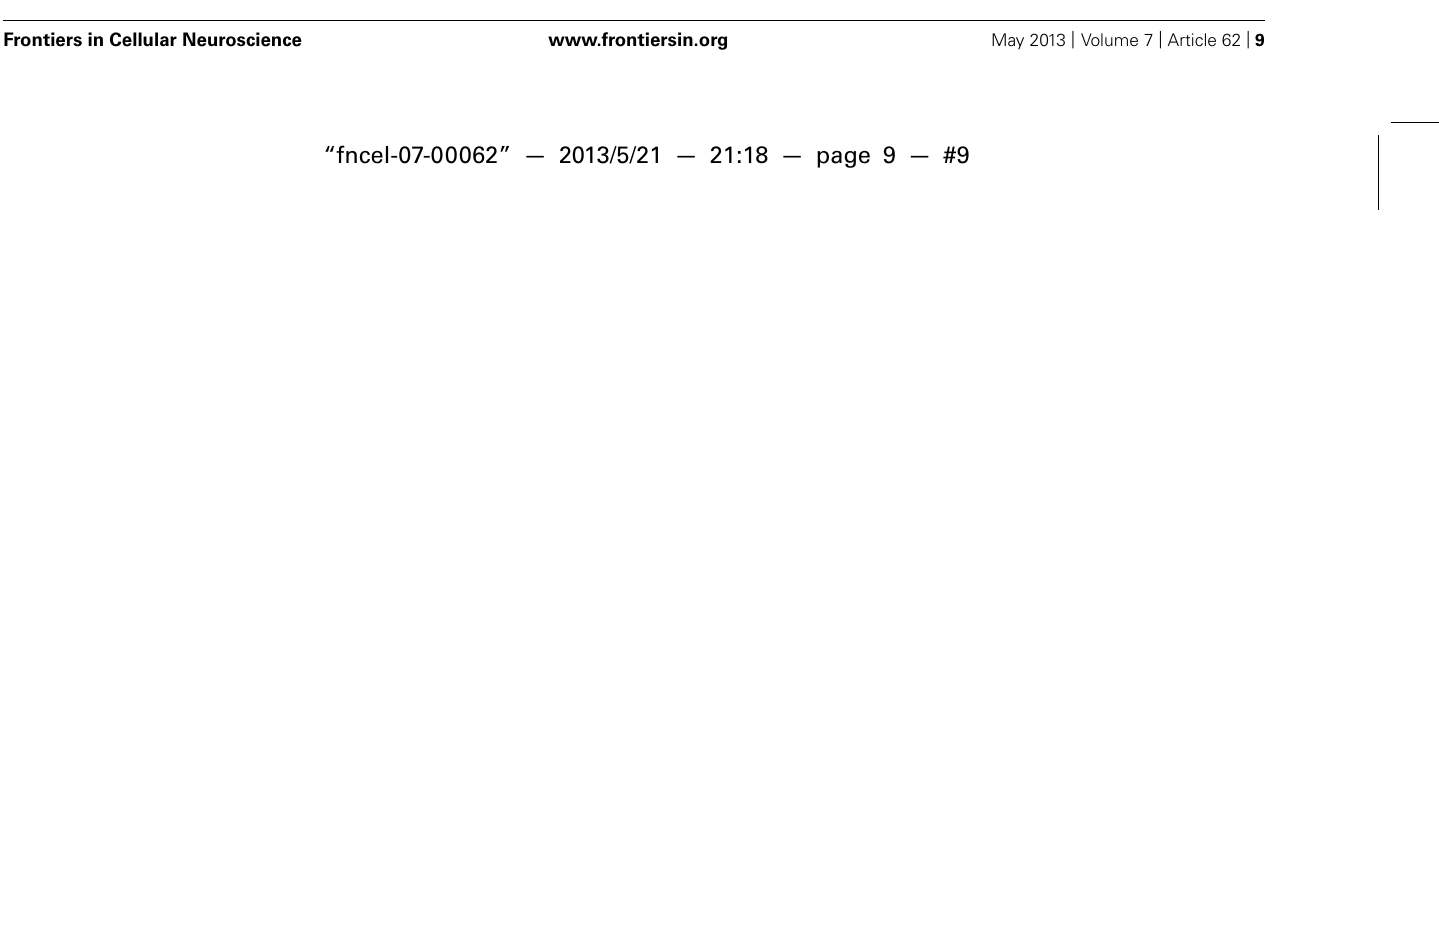
n = 16) hemisphere. C57BL/6J mice were injected into the right lateral ventricle 10 days before histology. Spine density in basal (C,D) and apical (A,B) dendrites. Data are mean ±